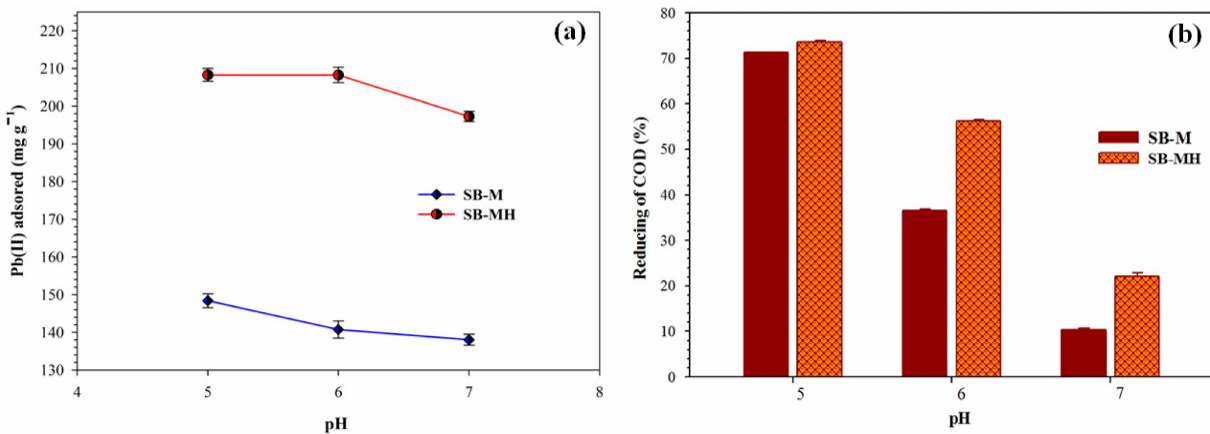
Figure 5. ( a ) The concentration of Pb(II) ion adsorption capacity and ( b ) reduction of COD on adsorption at various pH with a sample volume of 300 mL, 360 min, shaking rate of 150